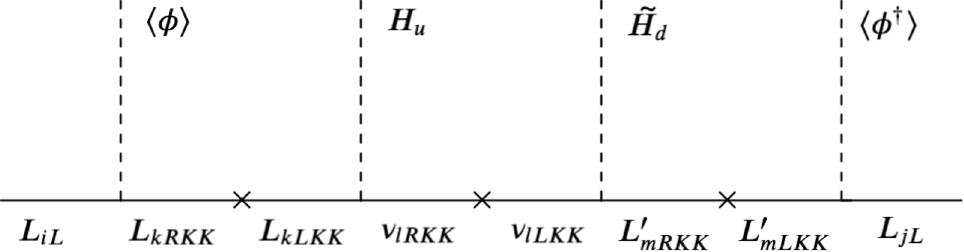
Figure 3 . Diagrams for the type Ib seesaw mechanism for neutrino